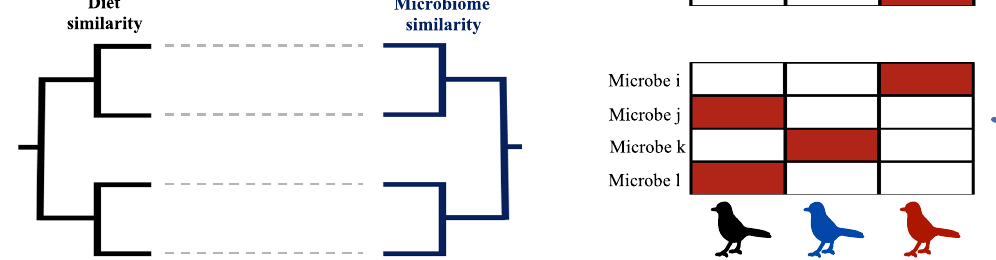
Figure 1. A conceptual overview of the investigated diet-related hypotheses. ( a ) Hypothesis 1: gut microbiome similarity is strongly associated with consumed diet similarity across all bird species irrespective of host phylogeny. ( b ) Hypothesis 2: host species-specific gut microbes are associated with certain diet (three different diets depicted) items, where different bird species (three different species depicted) harbour different microbial taxa that are associated with the same diet items. Red boxes represent significant correlations between diet components and gut microbes, while white boxes represent no